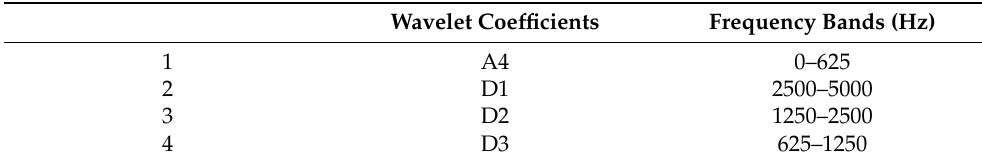
Table 2. The Frequency Band for the Wavelet